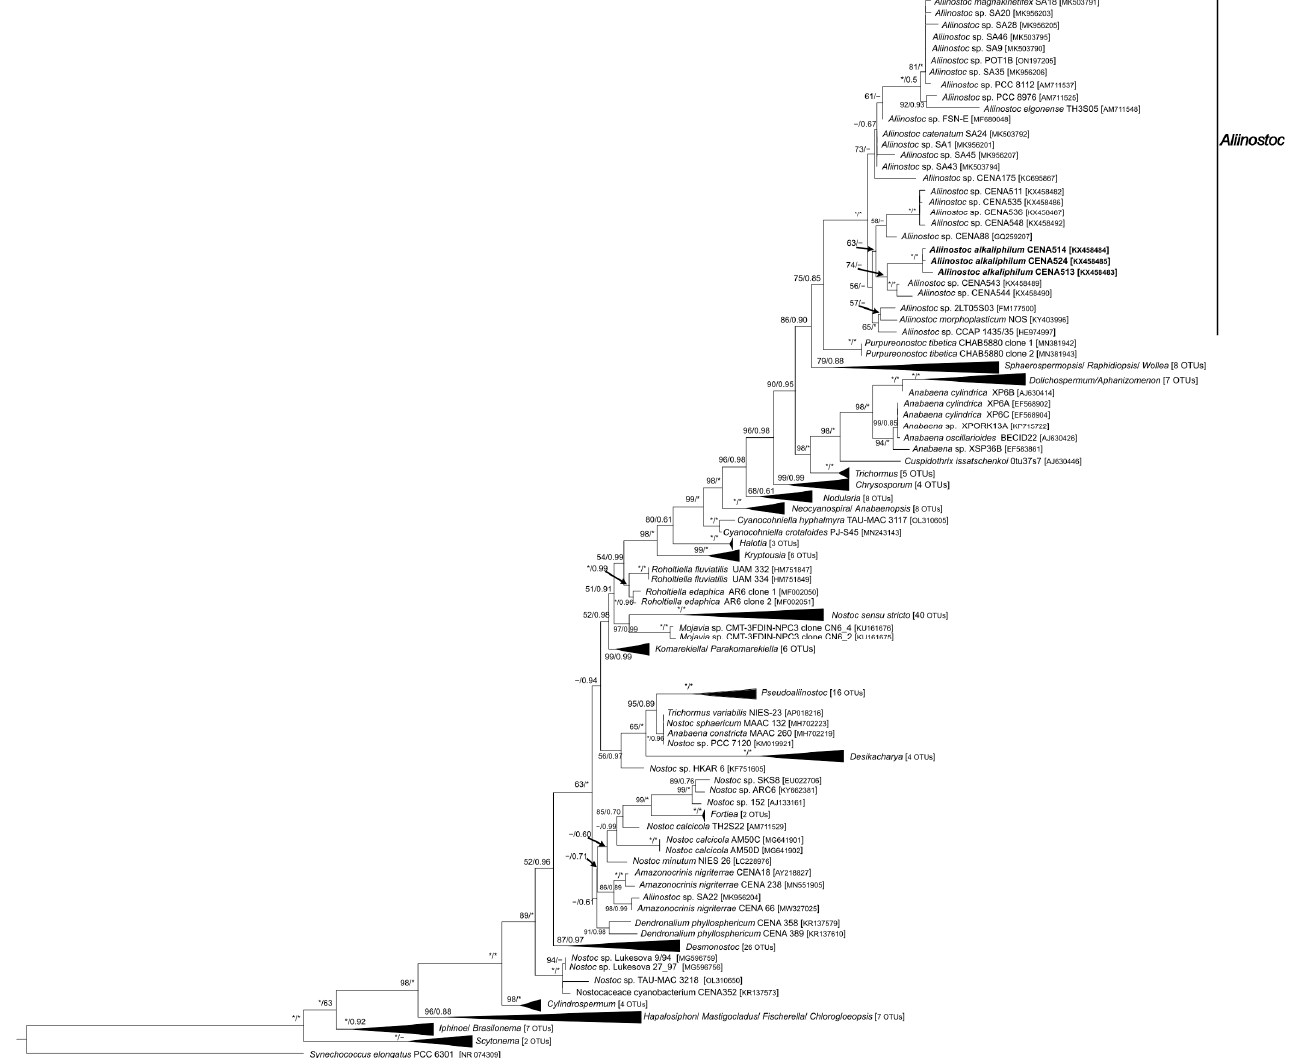
Figure 3. Phylogenetic relationships inferred from maximum likelihood analysis based on 16S rRNA sequences of Aliinostoc and related genera of Nostocales sensu Komarek et al. [13]. Sequences of Aliinostoc alkaliphilum CENA513 T , 514 and 524 are shown in bold. Numbers on nodes correspond to bootstrap values ( ≥ 50%) and posterior probabilities ( ≥ 0.50) obtained from maximum likelihood and Bayesian analyses, respectively. Asterisk (*) represents posterior probability of 1.0 for Bayesian analysis and bootstrap values of 100% for maximum likelihood analysis. Synechococcus elongatus PCC 6301 was the designated outgroup. GenBank accession numbers of sequences are given in brackets. The scale corresponds to substitutions/site.